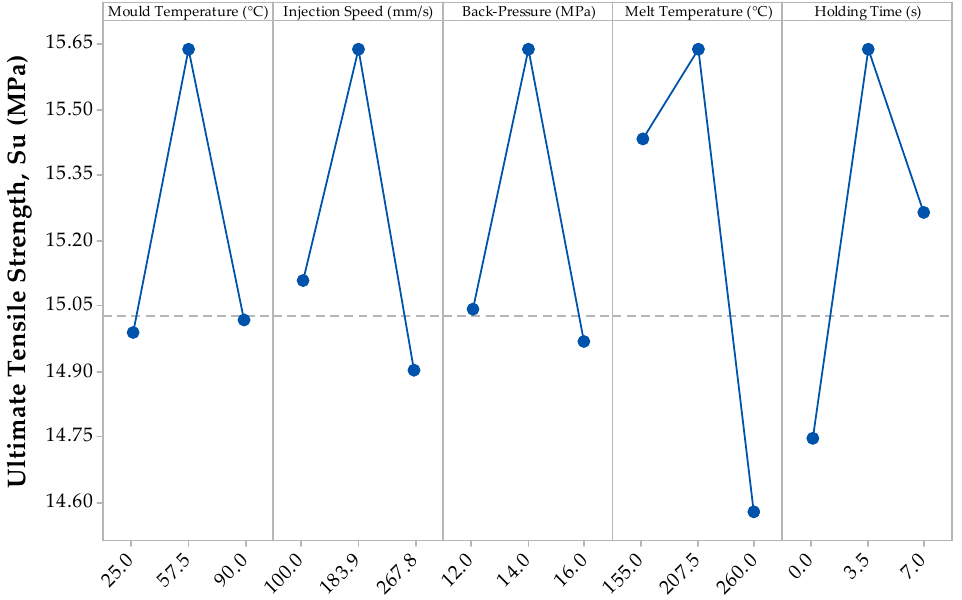
Figure 4. Main effects plot for the mean maximum tensile strength (S u ) results from the DoE. Figure 4. Main e ff ects plot for the mean maximum tensile strength (S u ) results from the DoE. Table 3. Analysis of variance linear model for ultimate tensile strength against processing